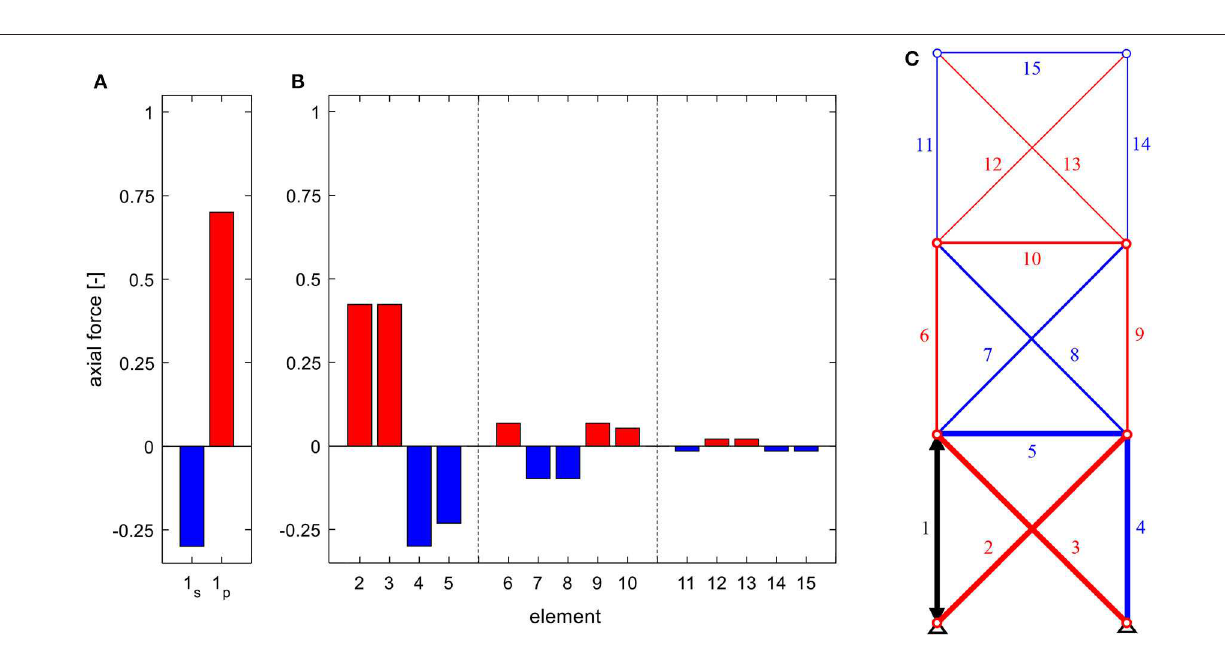
of axial forces (resp. internal force variables) for actuators in the bottom module (cf. Figure 10 ). Although the constraint forces from actuation can still be (partially) compensated along each substructure, the increasing stiffness of each module results in higher axial forces.